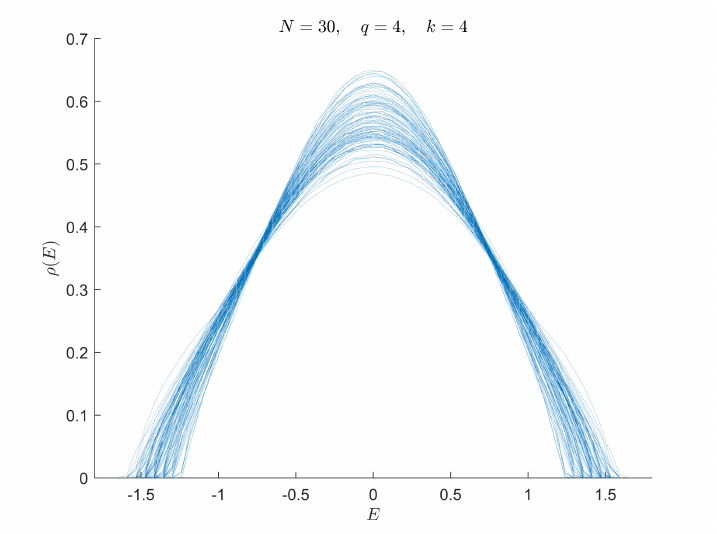
Figure 2 . The individual spectral densities of the sparse SYK Hamiltonian for 100 different realization of the